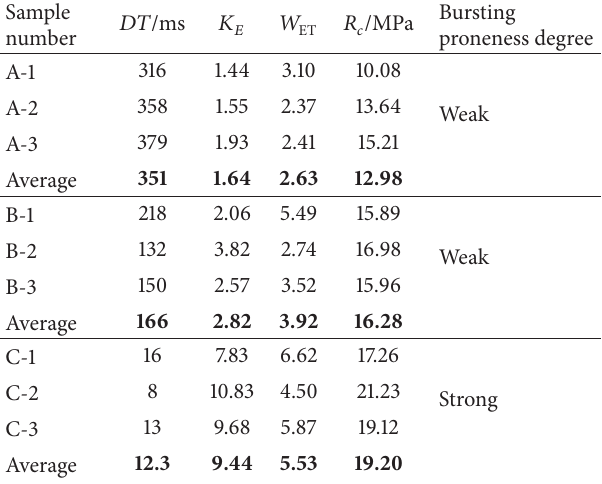
Table 3: Bursting proneness testing results of coal and coal-rock mass